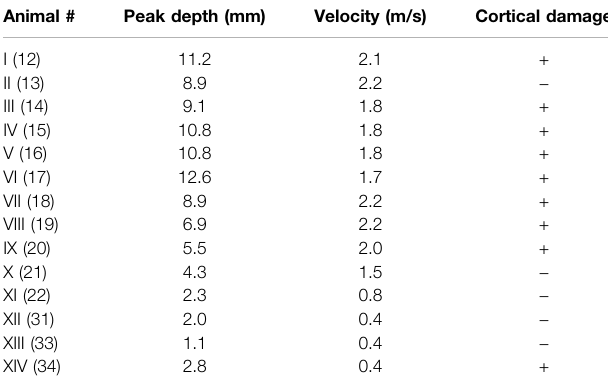
TABLE 1 | Experimental impact parameters and results of the CCI performed in vivo on the pig brain (De Kegel et al., 2021) for which medical imaging and histological assessment of CC were available. In case of detectable disruption of the cortical layer the “ Cortical damage ” is marked as “ + , ” otherwise as “ − . ” The animal number in parentheses refers to the numbering used in De Kegel et al.